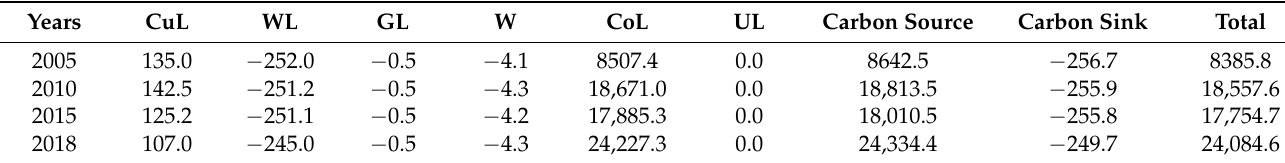
Table 7. Carbon emissions from different land-use types from 2005 to 2018